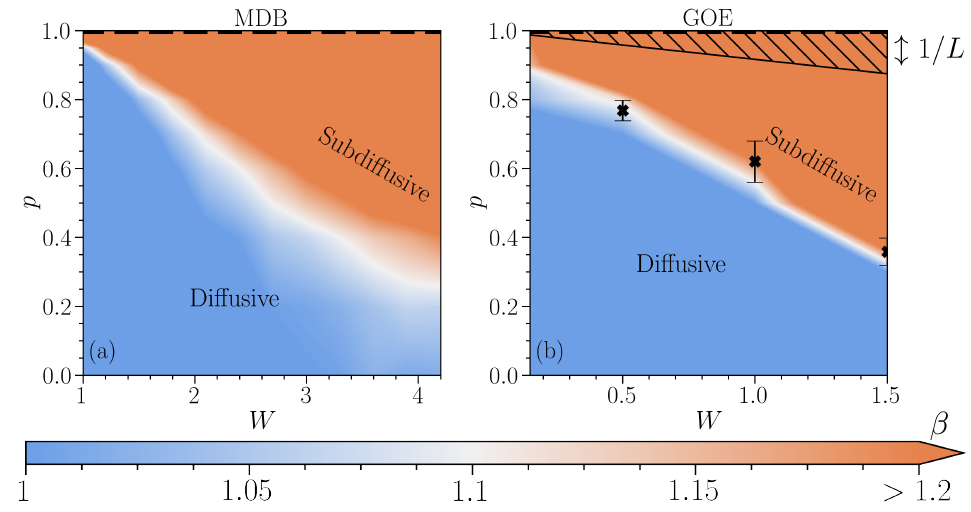
Figure 5: Transport phase diagram of the Anderson model for the MDB (a), and GOE (b) protocols. We obtain the data by extrapolating the system size scaling of the typical resistance R (cfr. Eq. (16)). Specifically, we consider system sizes L = 8 ÷ 256 and measure the typ / log L . The white region correspond to points which are diffusive up exponent β = log R typ = W ( p ) lies within this area, and signals a transition to two errorbars. The critical line W c c between a subdiffusive ( β > 1) and a diffusive ( β = 1) behavior. The black cross markers are examples of extrapolation points, with associated error estimations. The black dashed line p = 1, corresponds to no dephasing. In this limit, the system is always Anderson localized for any W > 0, with a resistance exponentially suppressed in system size (dashed line) The hatched region in the GOE correspond to Anderson localization which only extends in a vanishing region of the phase diagram in the thermodynamic limit where 1 − p = O ( 1 / L )